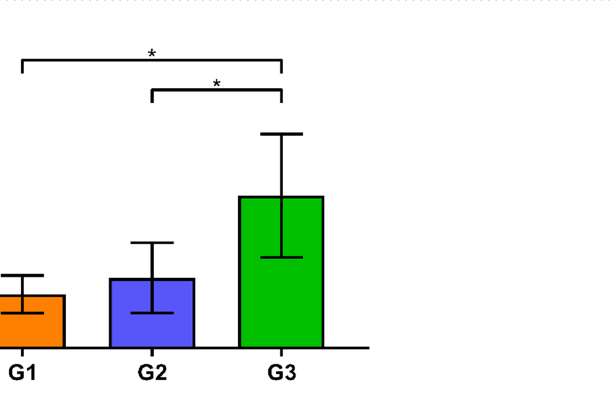
Figure 6. Maximal average relative decrease in the cross-sectional area (MaxMean%DecCSA) during reaming in the three study groups G1, G2 and G3 in terms of mean value and standard deviation, with stars indicating significant